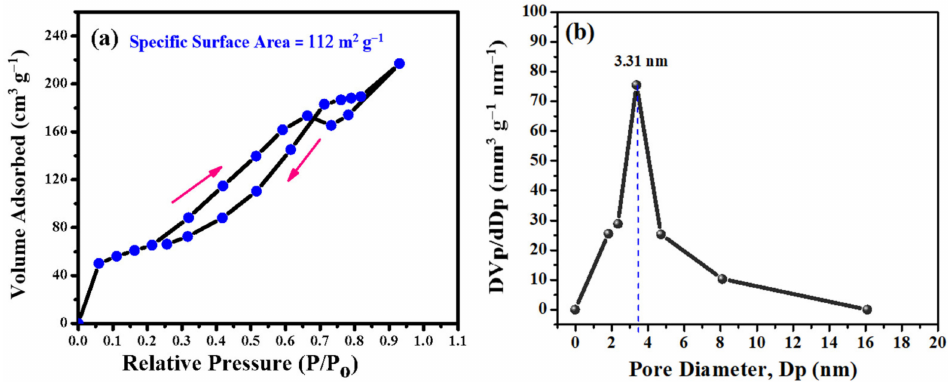
Figure 3. ( a ) N 2 adsorption–desorption isotherm and ( b ) pore size distribution plot of the Co–Pd@Al 2 O 3 bimetallic